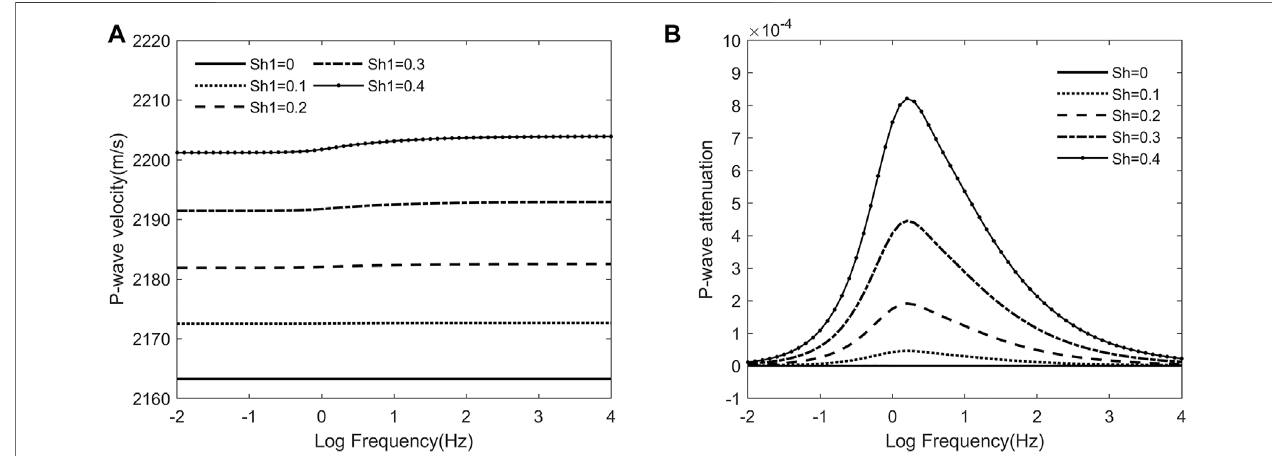
FIGURE 2 | P-wave velocity (A) and P-wave attenuation (B) vs. frequency curves at different hydrate contents in model A.